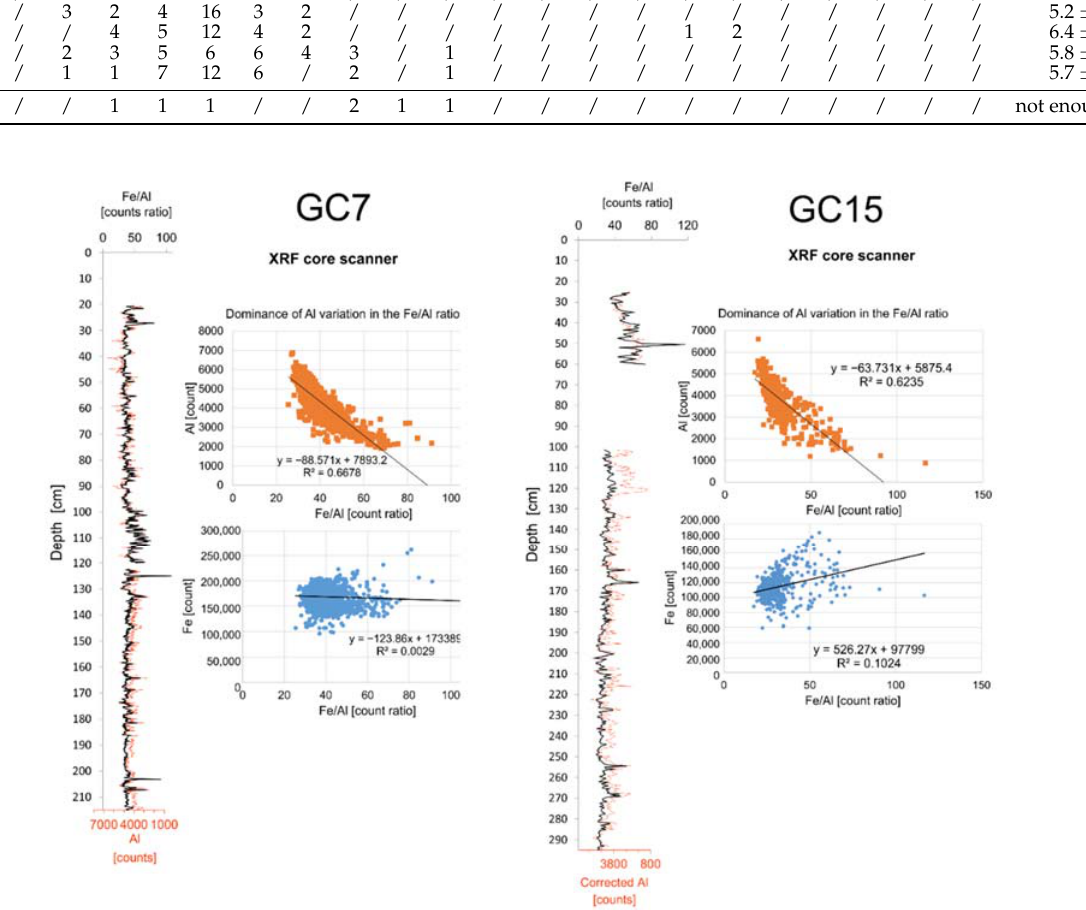
Figure A1. Domination of Al variations in the Fe/Al ratio in XRF core scanner measurements illus ‐ trated by the high correlation between Al count and Fe/Al count ratio in GC7 (R 2 = 0.67) and in GC15 (R 2 = 0.62), while in contrast, there is no correlation between Fe and Fe/Al (R 2 = 0 and 0.10 respec ‐ tively for GC7 and GC15).